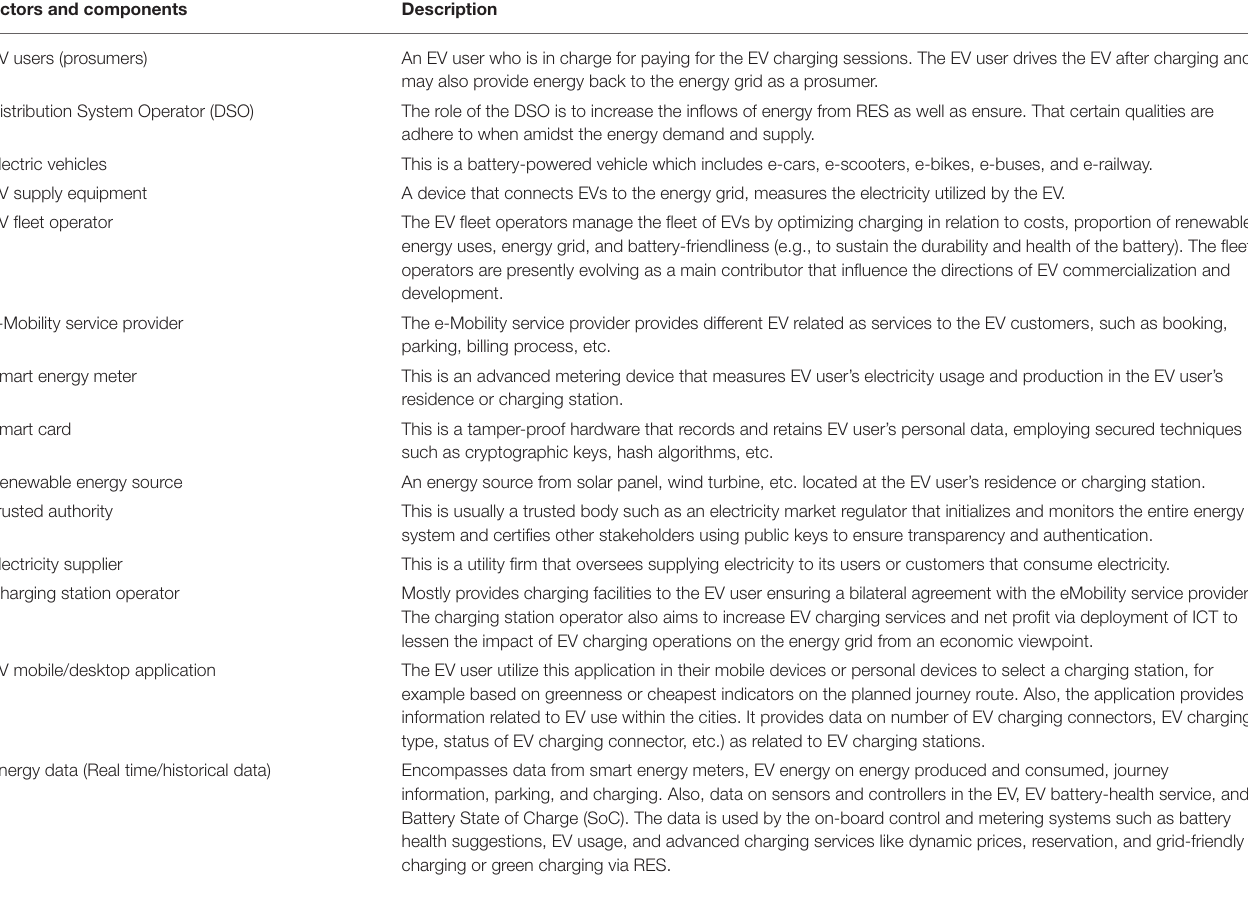
TABLE 1 | Actors and components in the energy as a service business model. Actors and components